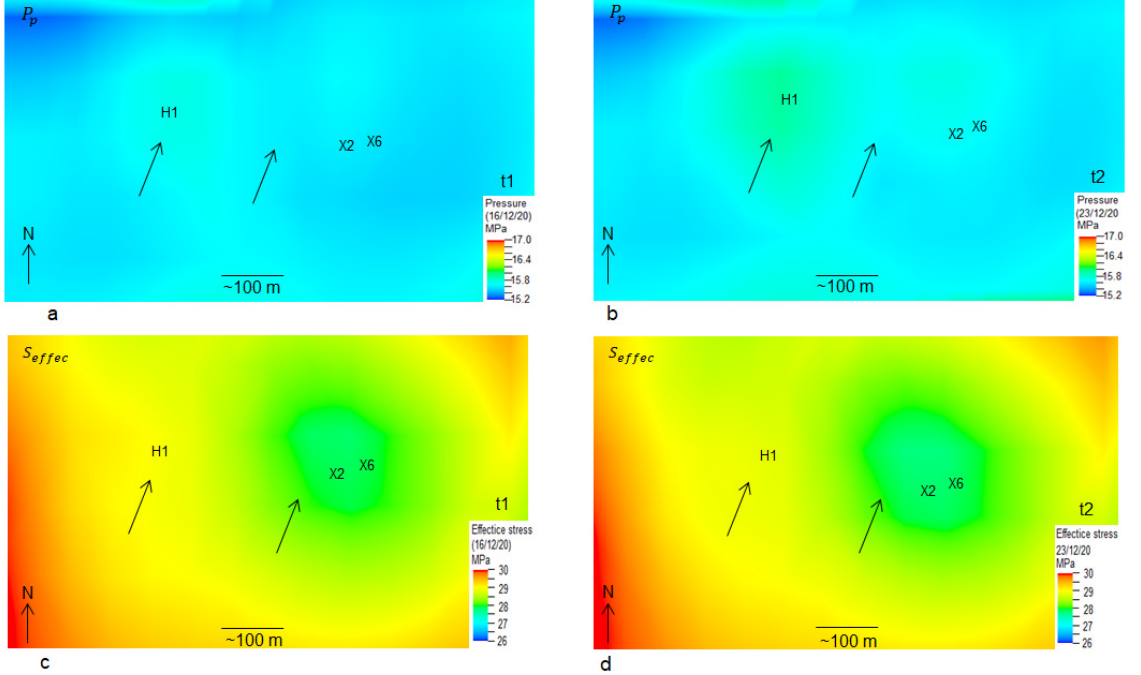
Figure 7. Pore pressure ( P p ) and effective stress ( S ef fec ) changes from t1 (9 December 2020) to t2 (23 December 2020) in the short-term case with three wells (X2, X6, and H1) without a water cut-off rate of 5 m 3 /day. The arrows show the location of maximum observed changes in P p and S ef fec from t1 to t2. The color scale is in MPa. ( a ) is pore pressure at time t1; ( b ) is pore pressure at time t2; ( c ) is effective stress at time t1; ( d ) is effective stress at time t2.